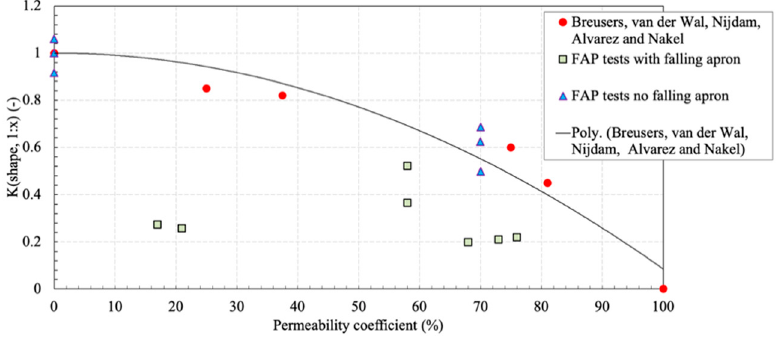
Figure18. K shape, 1:x asanapproximatefunctionofthepermeabilitycoe ffi Figure 18. K shape, 1:x as an approximate function of the permeability coefficient in tests with